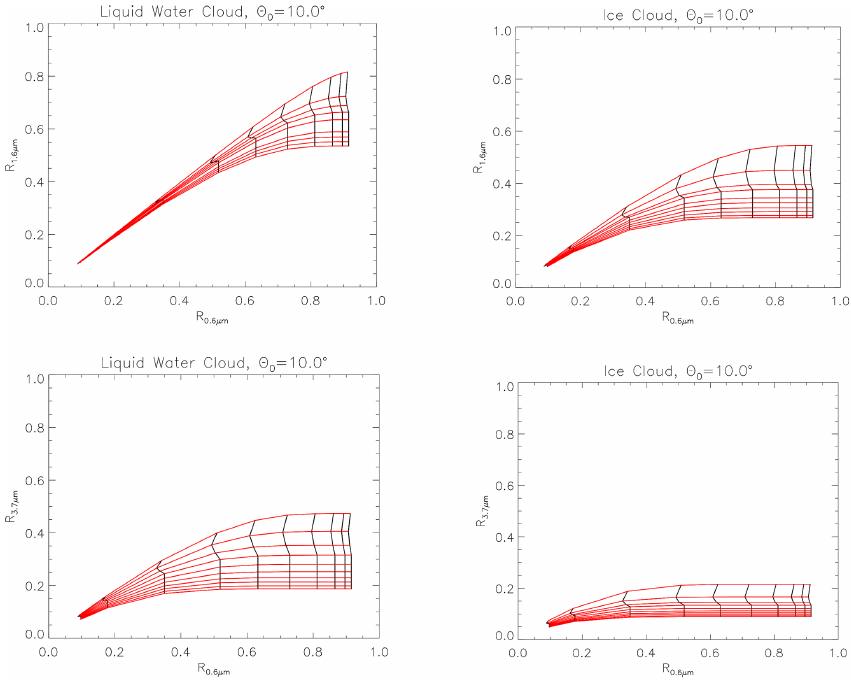
Figure 3. Reflectance of liquid water (left) and ice (right) clouds at the absorbing versus the non-absorbing channel for the absorbing channel being centered at 1.6µm (top) and 3.7µm (bottom). Cloud reflectance is simulated with the two-stream scheme of Coakley and Chylek (1975) for a sun zenith angle or 10 ◦ and for various optical depths and effective radii (see text for